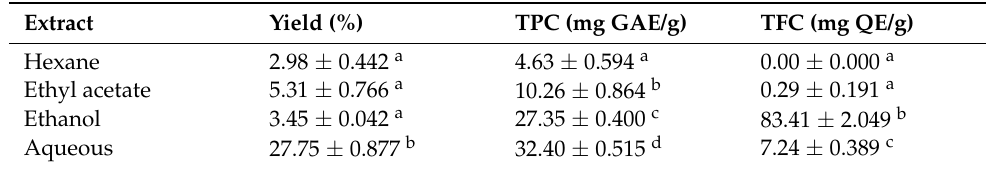
Table 1. Yield percentage and phytochemical content of S. platensis